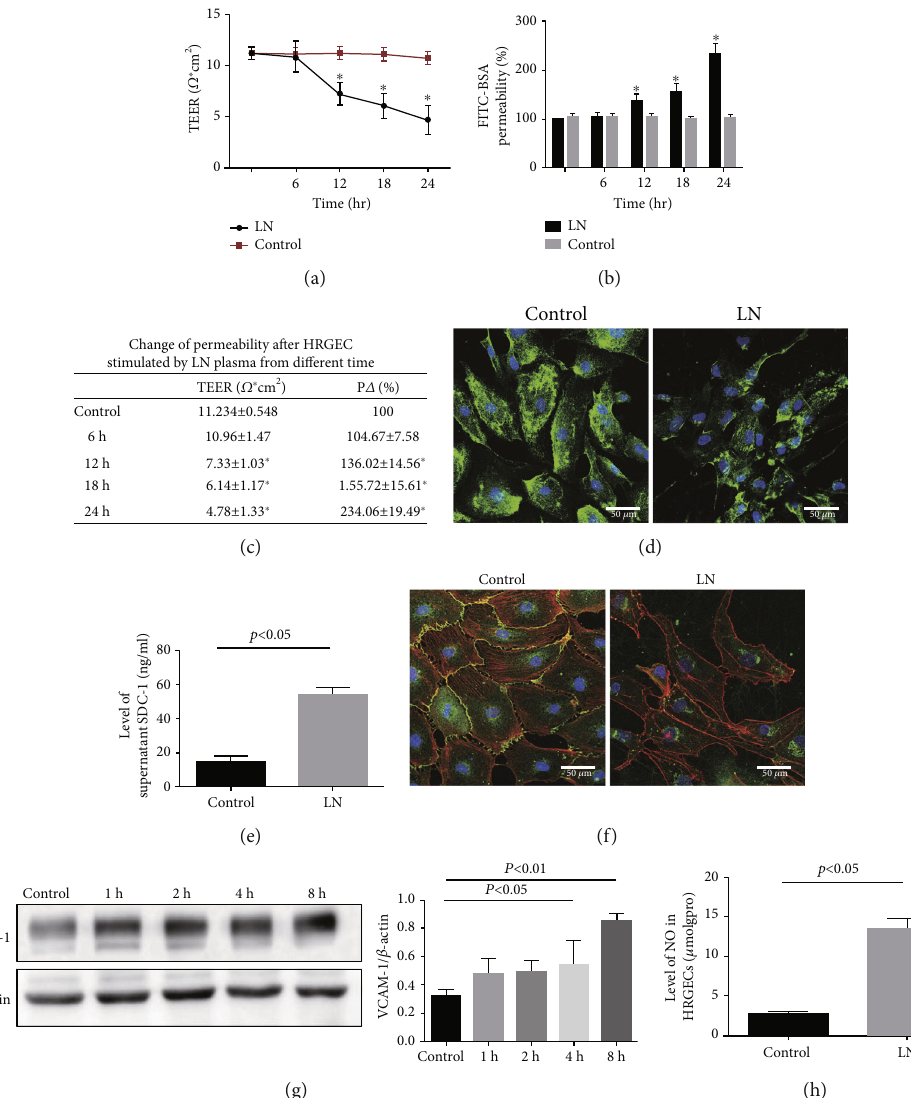
Figure 3: HRGEC injury contributed to the upregulation of glomerular fi ltration membrane permeability in LN. (a) TEER of HRGECs stimulated by LN plasma at di ff erent time was measured ( n = 5 ). (b) HRGEC glomerular fi ltration membrane permeability was assessed by the FITC-BSA method ( n = 5 ). (c) Change in TEER and glomerular fi ltration membrane permeability of HRGEC. (d) IF staining showing the expression of SDC-1 (green) in HRGECs. (e) The level of SDC-1 in supernatant was measured by ELISA ( n = 5 ). (f) Colocalization of VE-cadherin (green) and F-actin (red) in HRGECs was determined by IF staining. (g) Western blotting of VCAM-1 in LN plasma-stimulated HRGECs. (h) The level of NO in HRGECs was measured ( n = 5 ). p < 0 : 05 vs. control group. TEER: transendothelial electrical